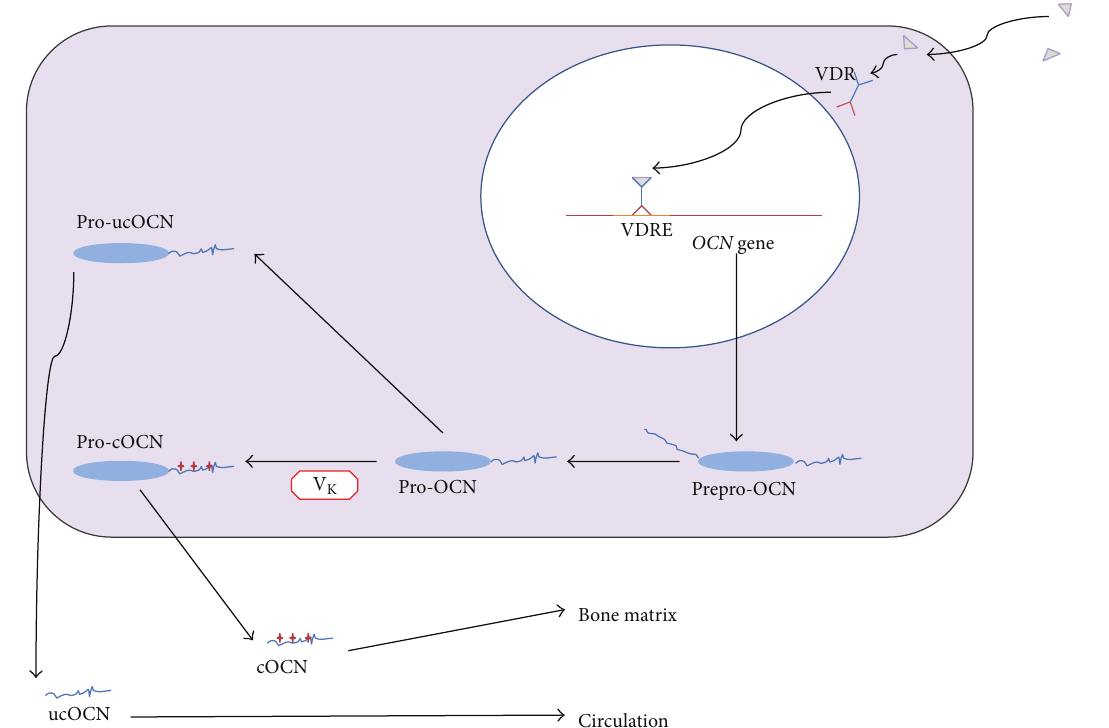
Figure 2: OCN is synthesized in osteoblasts. OCN is mainly expressed in osteoblasts. After transcription, which is stimulated by Vitamin D, the prepro-OCN peptide will be proteolysed and forms a prepeptide (23 aa) and a pro-OCN peptide (75 aa). The pro-OCN peptide can be carboxylatedatGluresidues17,21,and24,resultinginformationofGlaresiduesinaVitaminKdependentprocess.Generally,thisprocessonly occurs in a proportion of newly synthesized proosteocalcin. Then Gla and Glu pro-OCN peptides are subjected to a final proteolytic process that produces cOCN and ucOCN. Both forms are released from osteoblasts in a process which is calcium dependent. While the carboxylated Gla residues are involved in calcium and hydroxyapatite binding, allowing OCN deposition on mineralized bone matrix, ucOCN has a low affinity for hydroxyapatite and is more easily released into the circulation. OCN, osteocalcin; ucOCN, uncarboxylated osteocalcin; VDR, Vitamin D receptor; VDRE, Vitamin D receptor